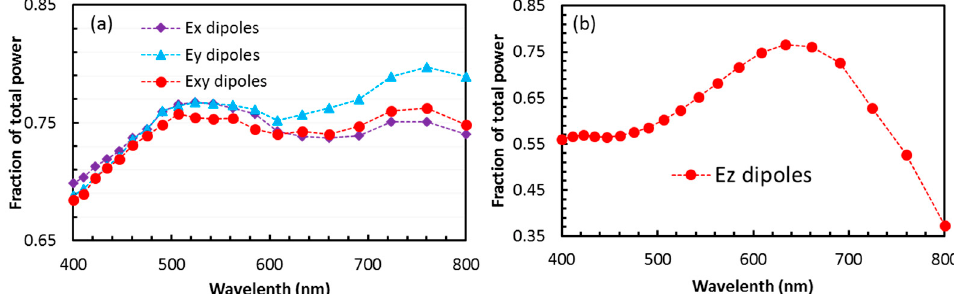
Figure 6. Fraction of total emitted power as a function of wavelengths with an exposure threshold of 35% I max for the E x , E y , and E xy dipoles ( a ), and the E z dipoles ( b ) for the OLED patterned with the graded photonic super-crystal with a sub-unit cell size of 9 a × 12 a ( a = 750 nm).